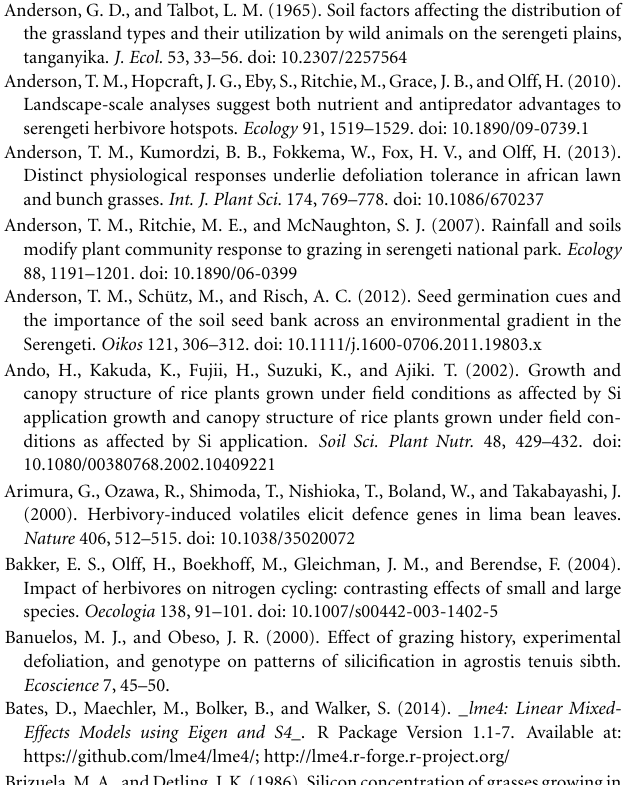
Table S1 | Results from linear mixed model in R testing for interactions between species and water on foliar silica accumulation. Block was included as a random effect. P values in bold indicate significance at α = 0.05. Table S2 | Summary of studies included in literature review of induced silica response of Poaceae; colors in the “Defoliation Response” column correspond with Figure 4. In the Defoliation Response column, “0” indicates that a species exhibited less than a 20% relative change in foliar silica content in response to defoliation, while “ + ” indicates a ≥ 20% increase in silica, and a “ − ” indicates a ≥ 20% decrease in